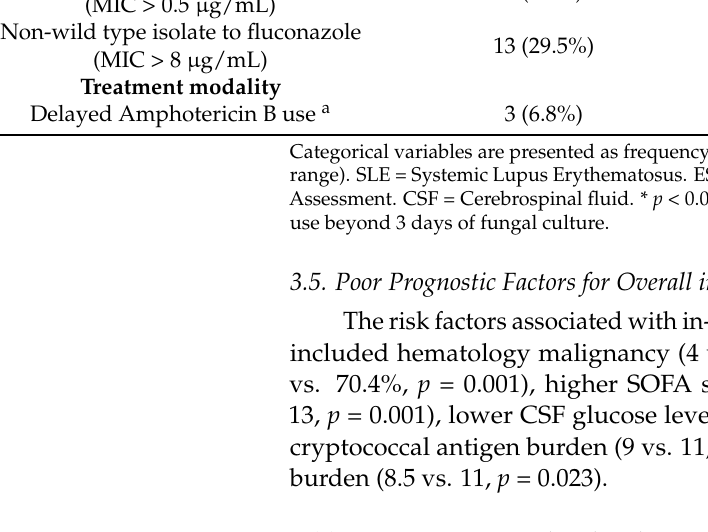
Table 4. Factors associated with in-hospital